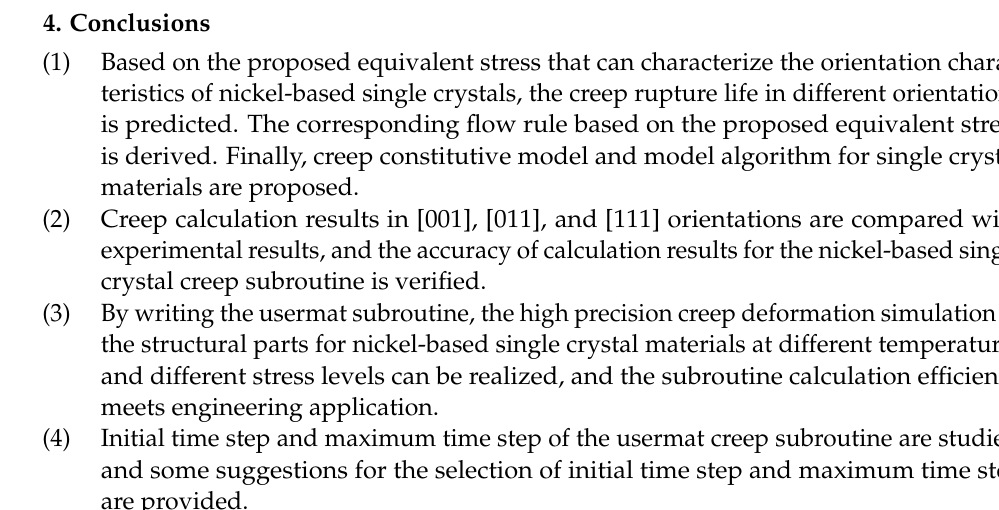
Figure 11. Influence of maximum time step and initial time step on creep calculation results. ( a ) Maximum time step, ( b ) Initial time